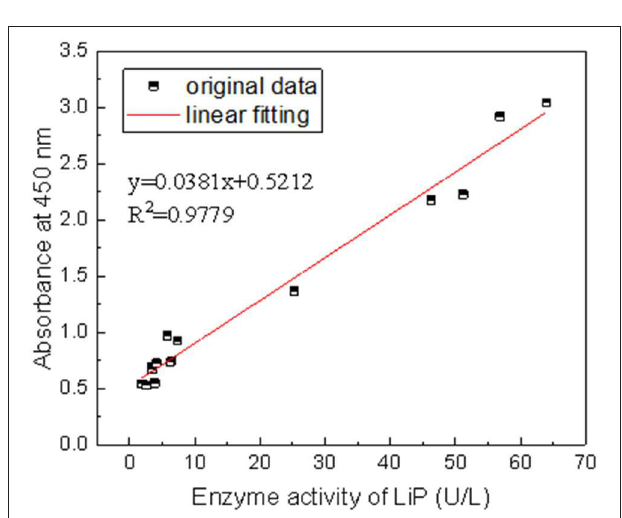
FIGURE 2 | Comparison of the activity of 15 single white rot fungi.